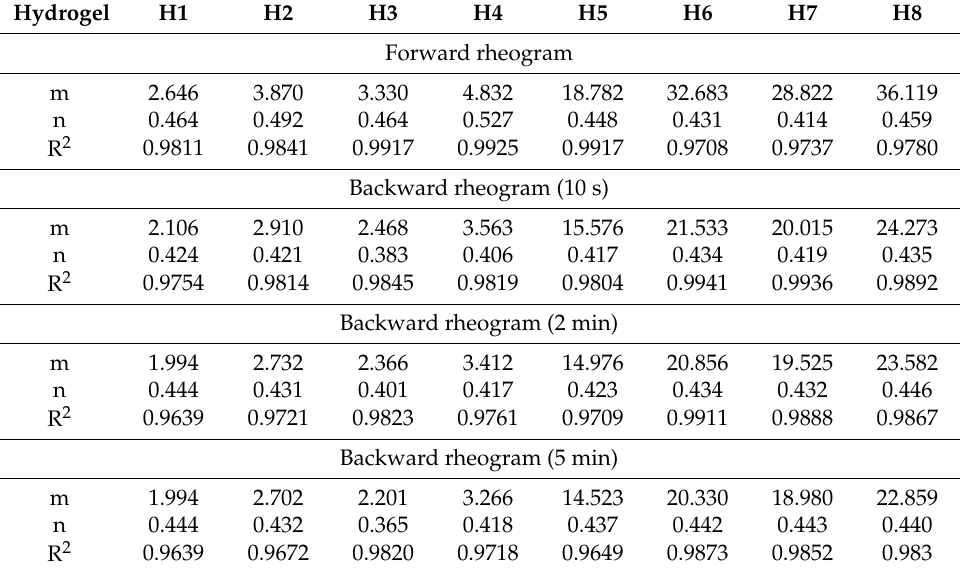
Table 4. Power law model parameters obtained in relation with forward and backward rheograms for hydrogels tested at 37 ˝